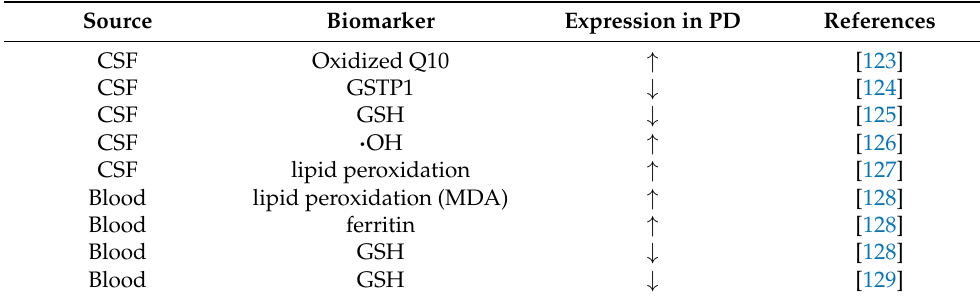
Table 3. Ferroptosis-related biomarkers of